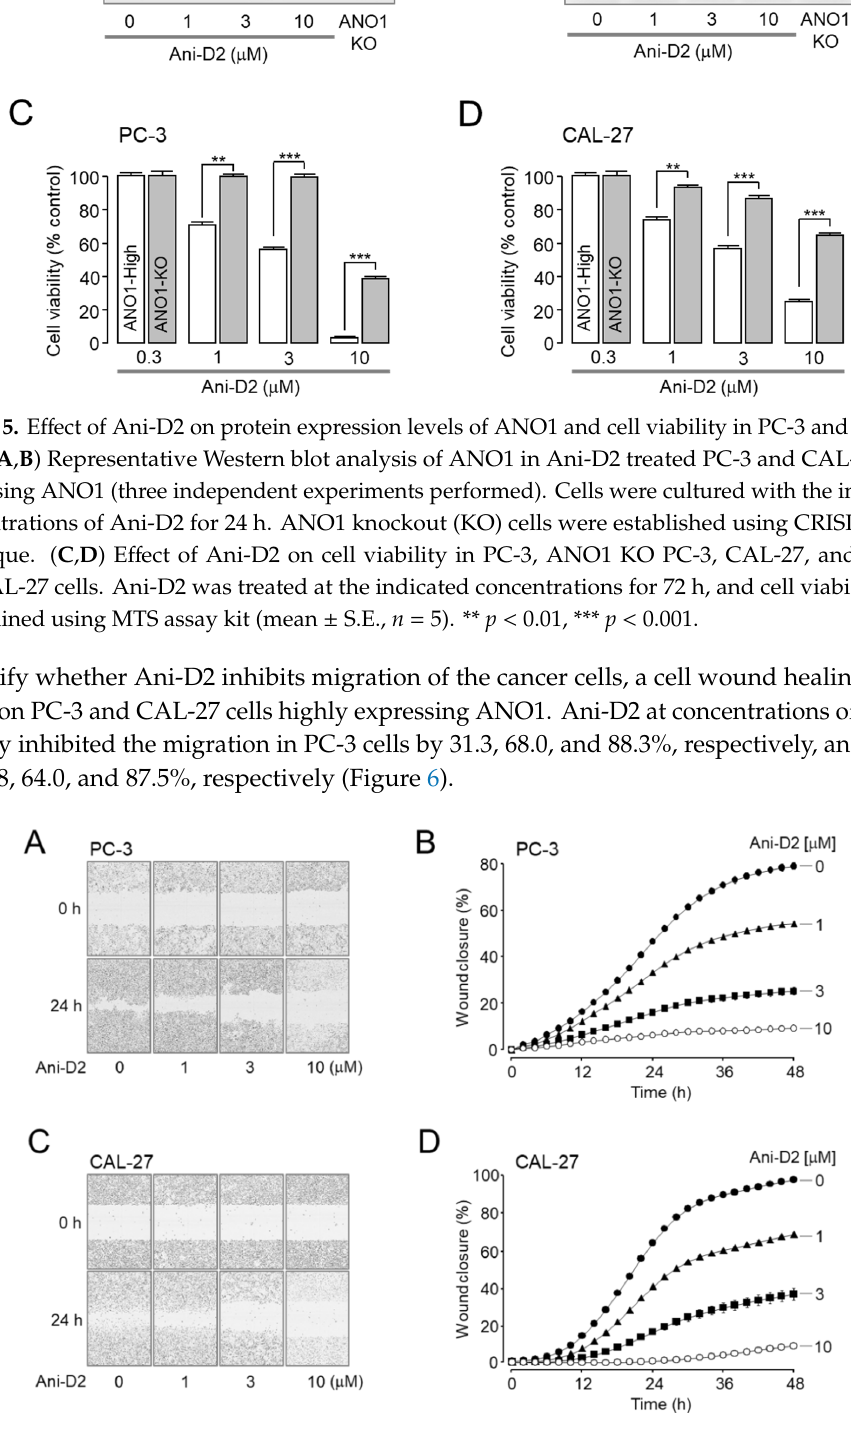
Figure 6. Effect of Ani-D2 on cell migration in PC-3 and CAL-27 cells. ( A , B ) Wound healing assay was performed in PC-3 cells. Cells were treated with Ani-D2 and representative images were taken at 0 and 24 h post wounding ( × 10). The wound closure was measured for 48 h (mean ± S.E., n = 3–4). ( C , D )